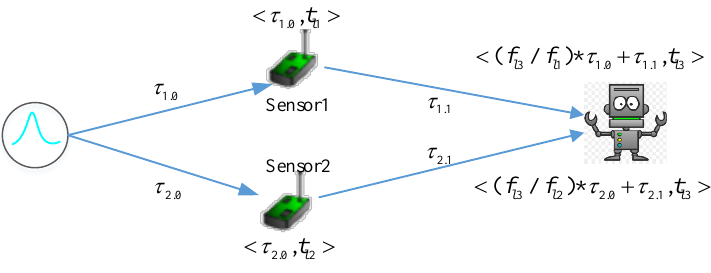
Figure 5. Relative time model with frequency revised.